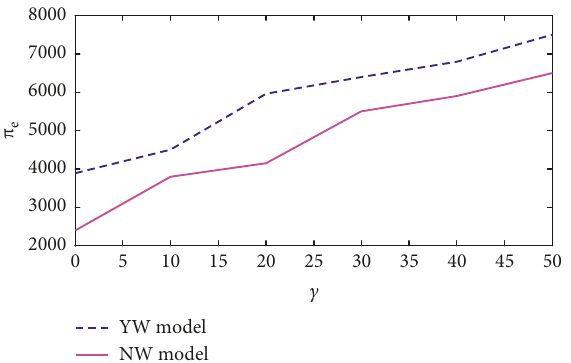
Figure 9: The impact of c on the e-commerce platform’s profit under the NW model and YW